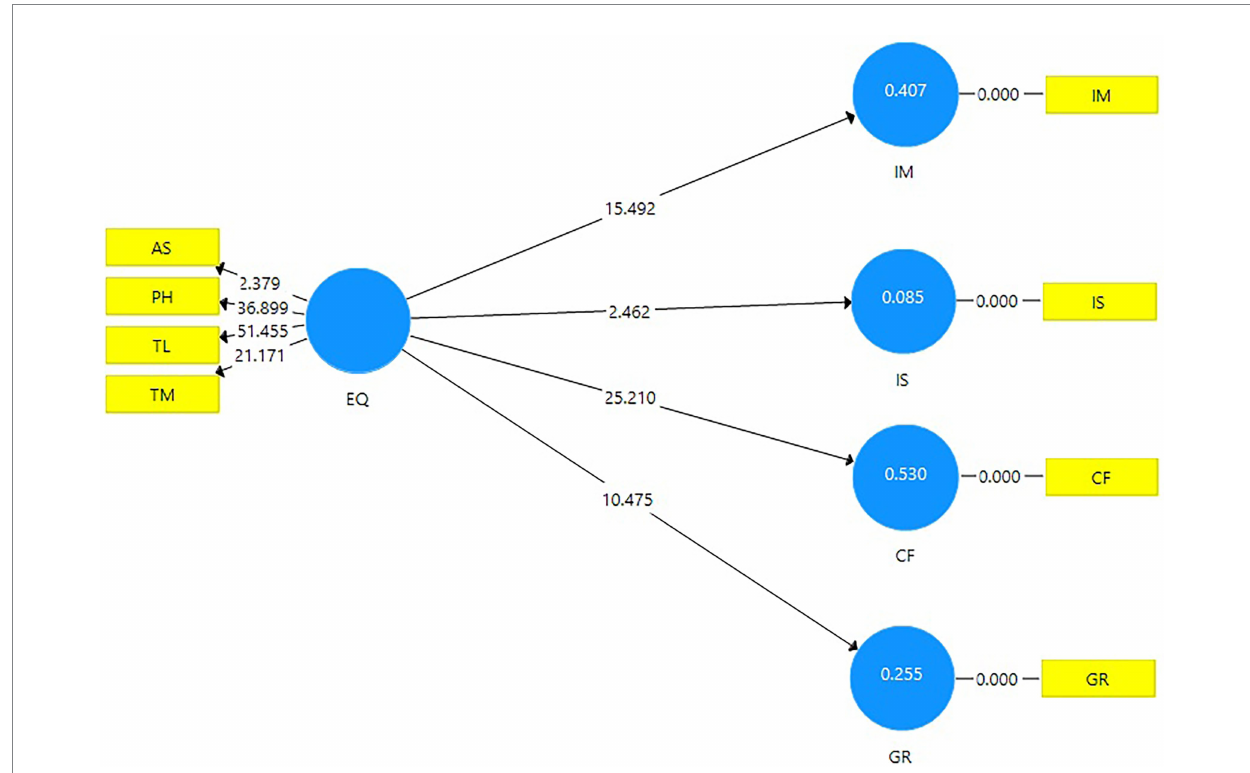
FIGURE 2 Structural model assessment.